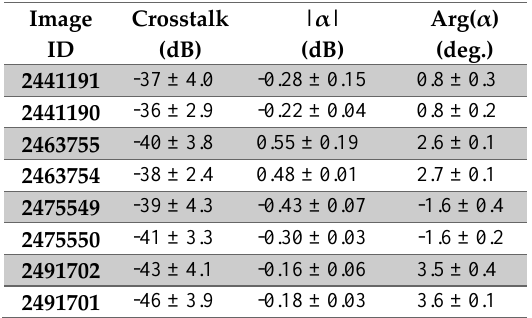
Table 2. Polarization residual errors after PolCAL To give a quantitative results, we calculated the average residual errors along the image range, see in Table 2. The results shows that the crosstalk of these images varies from - 36dB to -46dB, and the channel imbalance varies from -0.43dB to 0.55dB with angle varying from -1.6 to 3.6 degree.